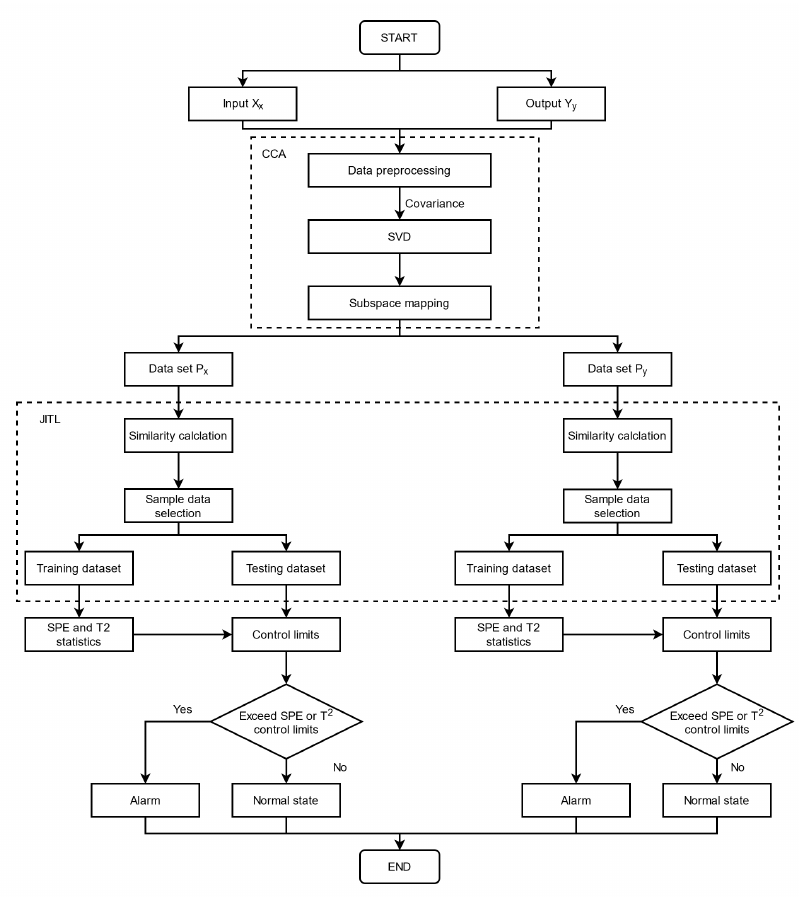
Figure 2. Flowchart of the proposed CCA-JITL FD